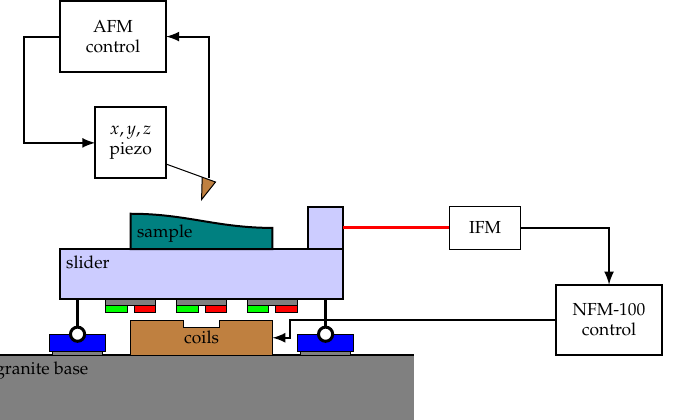
Figure 1. Side view of working principle of the planar nanopositioning machine and the installed tip-based system.